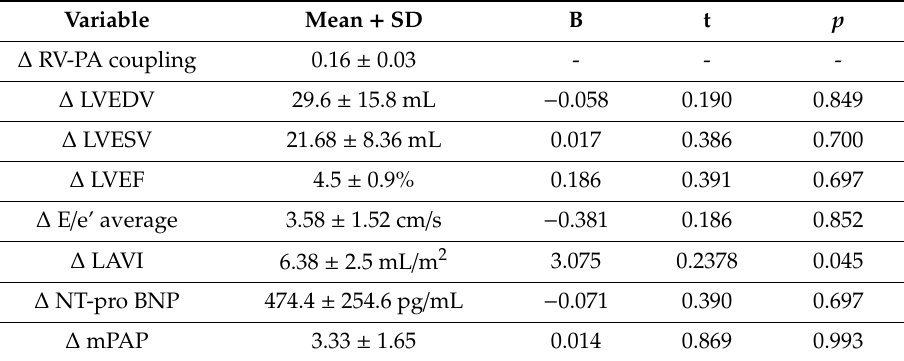
Table 3. Multiple linear regression analysis on the ∆ RV-PA